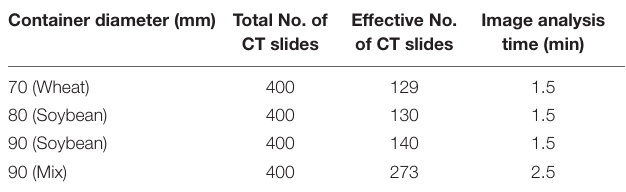
TABLE 1 | Summary of total CT slides, effective CT slides, and image analysis times for different sizes of containers.